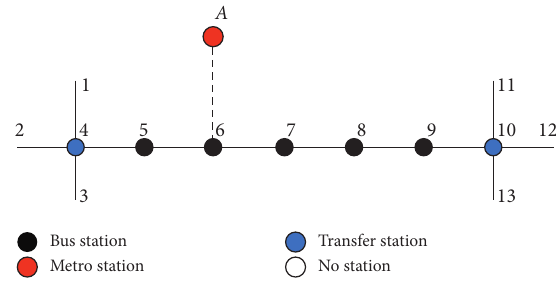
Figure 3: Modified bus routes layout.